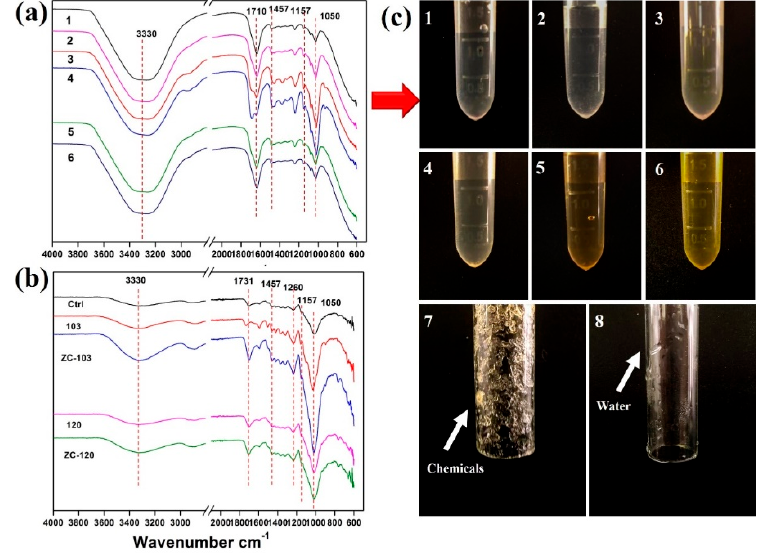
Figure 6. Fourier-transform infrared (FTIR) spectra of samples treated with different methods: ( a ) shows the FTIR of the samples in different treatments (Ctrl: untreated wood samples; group 1:10% DM + 10% MA; group 2:10% DM + 10% MA + ZnCl 2 ; group 3:10% DM + 10% MA, cured at 103 °C; group 4:10% DM + 10% MA + ZnCl 2 , cured at 103 °C; group 5:10% DM + 10% MA, cured at 120 °C; group 6:10% DM + 10% MA + ZnCl 2 , cured at 120 °C; group 7:10% DM + 10% MA, solidified at 120 °C until the water evaporation was complete; group 8:10% DM + 10% MA+ ZnCl 2 , solidified at 120 °C until the water evaporation was complete. ( b ) Here, the FTIR spectra of the modified samples in different treatment groups are shown, and ( c ) shows the change in the color of the chemicals when heated to different temperatures at 10% MA.